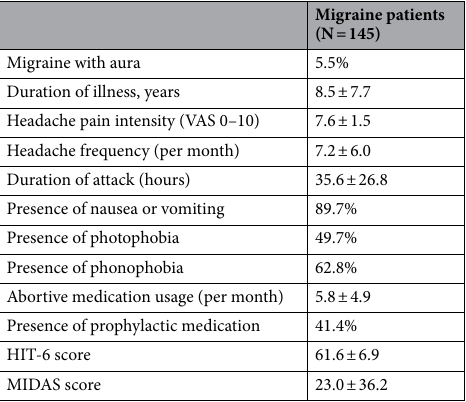
Table 2. headache characteristics of migraine patients.